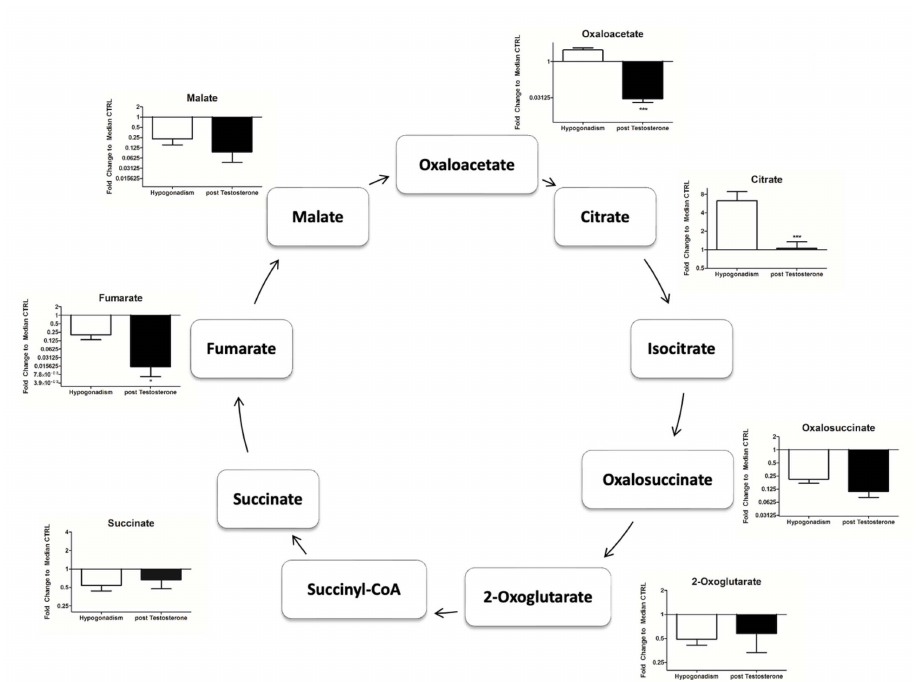
Figure 4. Intermediates of TCA measured in the plasma of hypogonadal patients before and after TRT, revealing that this metabolic pathway was still reduced after therapy. All data are shown as mean ± SEM of fold-change relative to the metabolite levels in controls. * p < 0.05, *** p < 0.001.